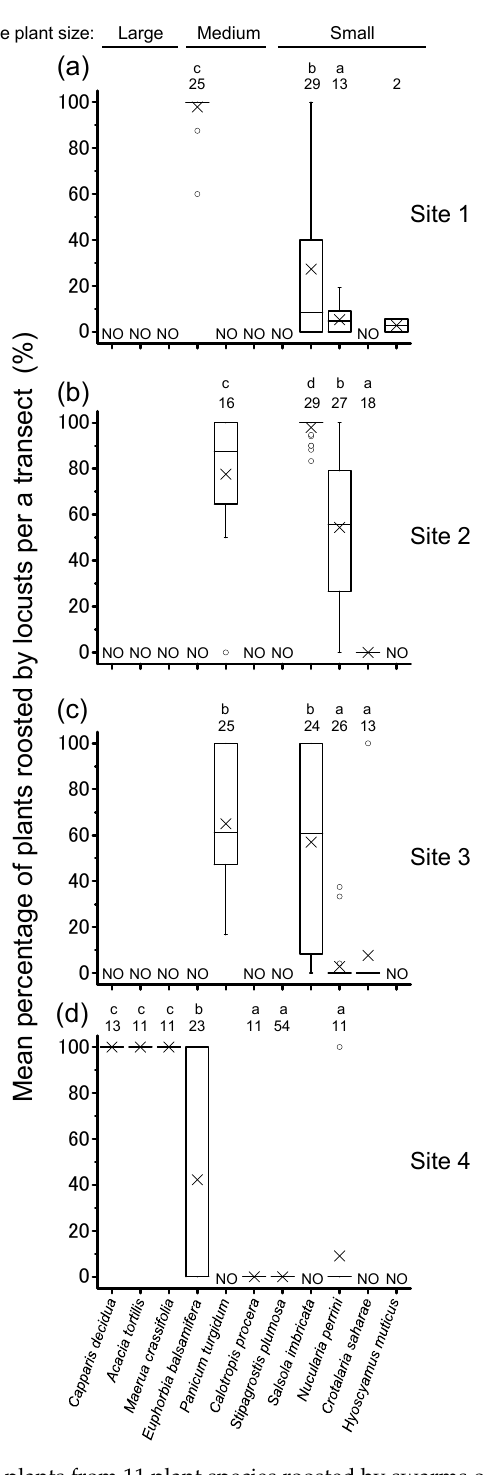
Figure 3. Mean percentage of plants from 11 plant species roosted by swarms of Schistocerca gregaria at night at four survey sites [Site 1: ( a ), Site 2: ( b ), Site 3: ( c ), and Site 4: ( d )]. Each box plot displays the median value with the ends of the boxes representing the 25th and 75th percentiles and the ends of the lines representing the 10th and 90th percentiles. Crosses indicate mean values and open circles are outliers. Different letters above each bar indicate significant differences at p < 0.05 based on a Tukey-Kramer HSD test after arc-sine transformation. Numbers above bars indicate sample sizes (numbers of transects which certain plant species were recorded). “NO” in the figure indicates absence of the plant species at the study site.